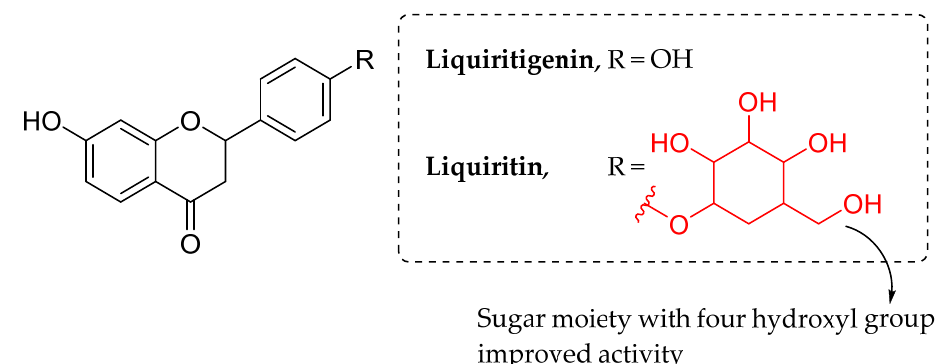
Figure 20. The chemical structure of tested flavonoids [86].